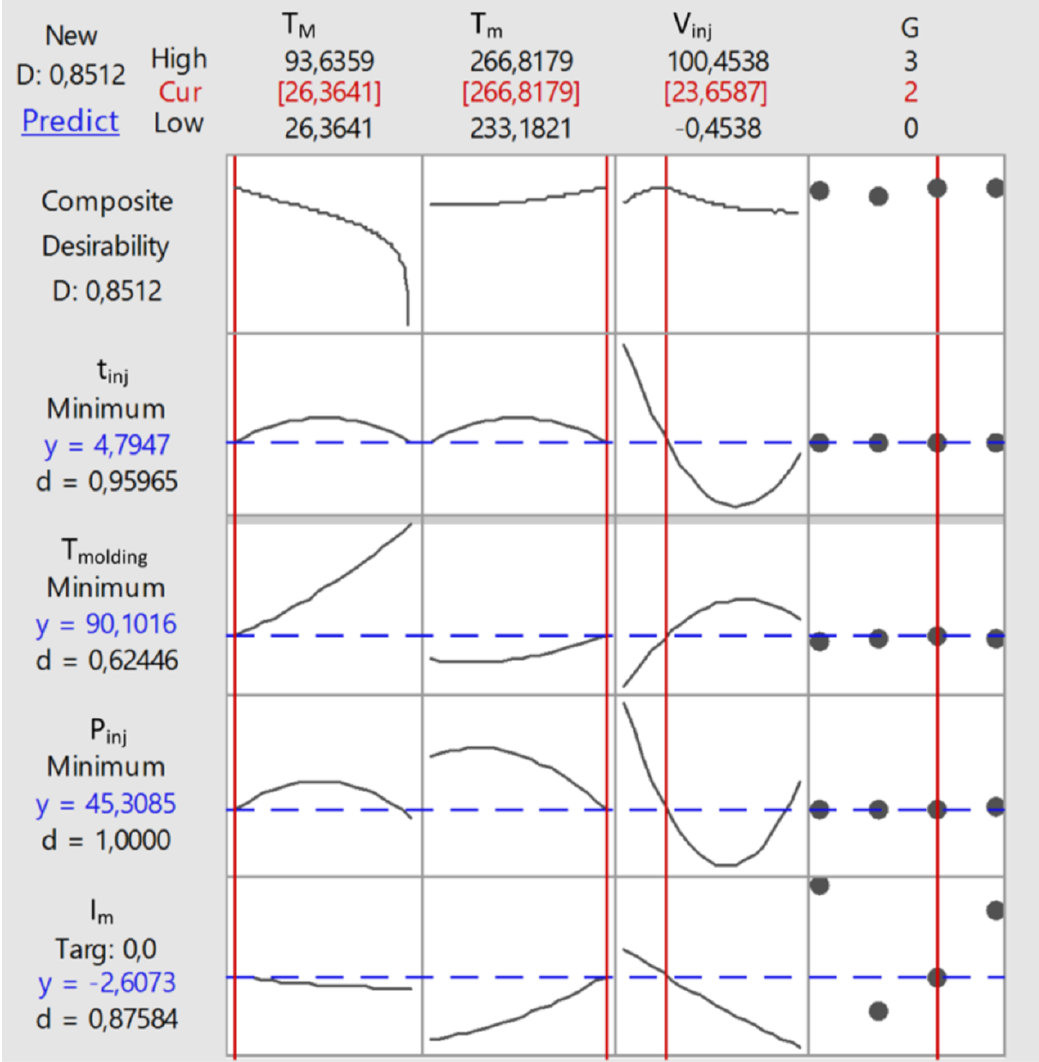
Figure 4. Graphical summary of RSM optimization results.